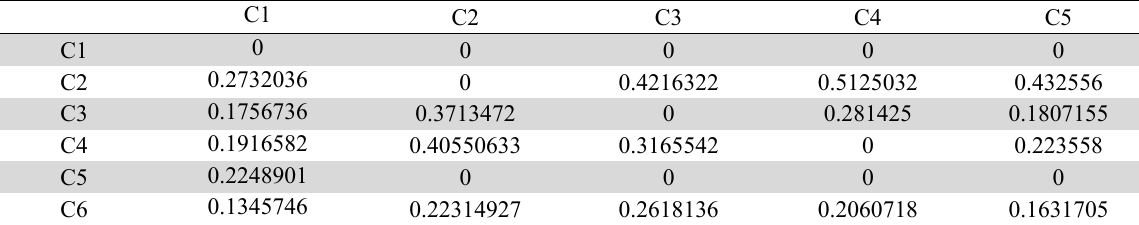
Results of calculating the matrix W22